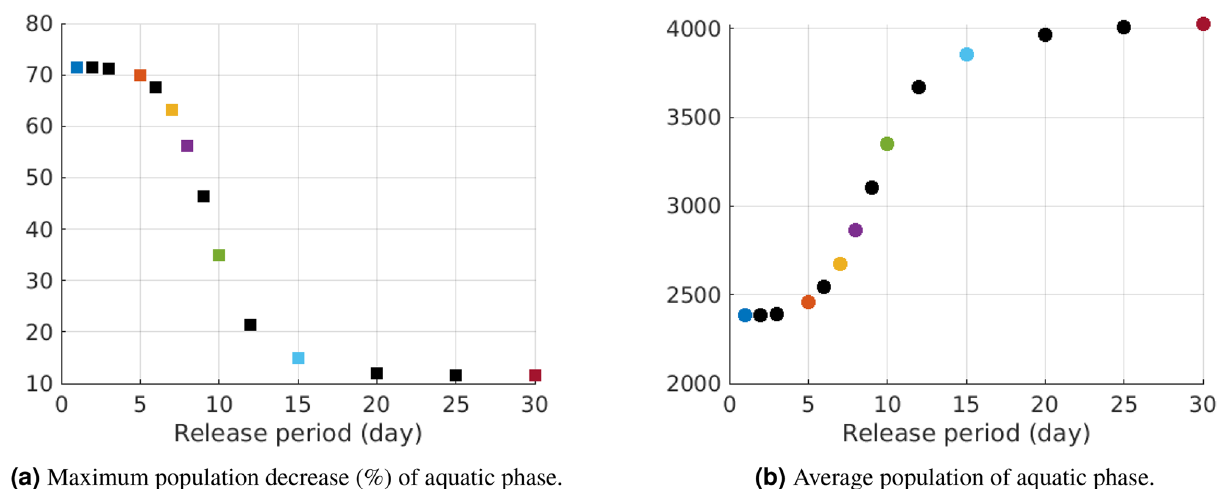
Figure 6. The impact of the frequency of GM mosquitoes release in 100 days simulations. The results plotted with the colored points correspond to the simulations presented in Fig. 5. The total amount of GM mosquitoes in 30 day period is fixed in all